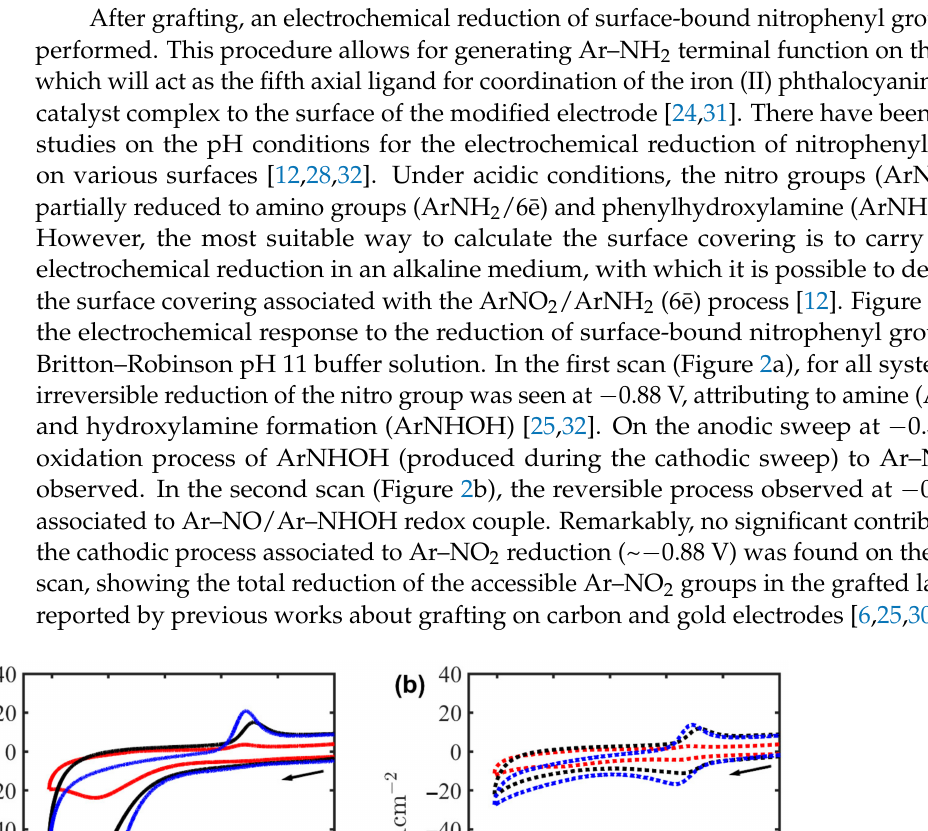
Figure 1. ( a ) First (solid line) and second (dotted line) CV modification for i -ArNO 2 (black line), mL -ArNO 2 (red line); ( b ) time-current curve to ML -ArNO 2 (blue line) recorded in ACN 0.1M TBAP on a gold electrode.